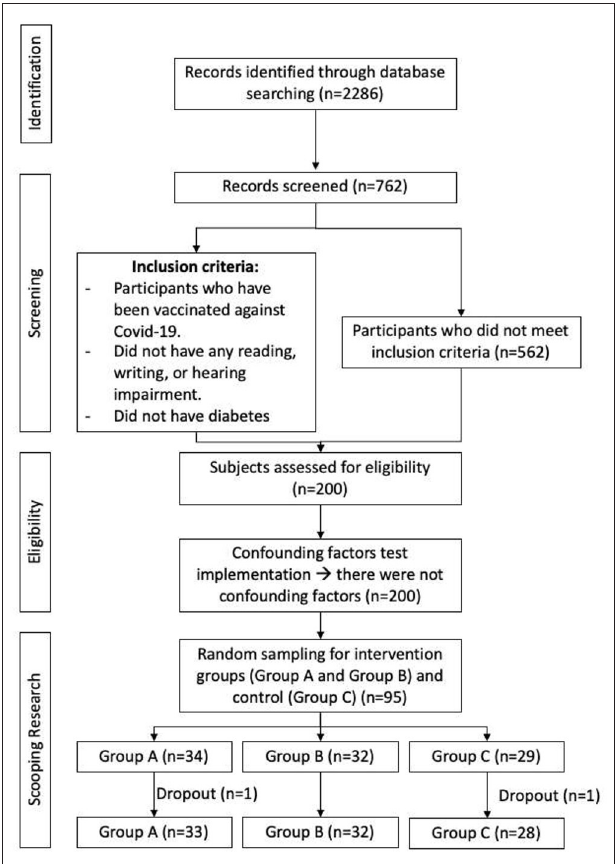
FIGURE 1 | Consort flow chart of participants